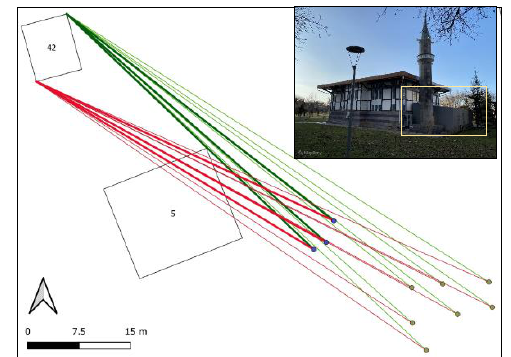
Figure 15. A misclassified reference data as “no target” (Image